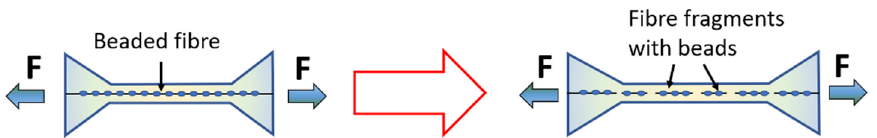
Figure 2. Schematic representation of a single fibre fragmentation test for a beaded fibre. Dog- bone shaped epoxy sample with embedded fibre is subjected to tension until fibre fragmentation occurs. Fibre fragments are hypothesised to have beads present on them.